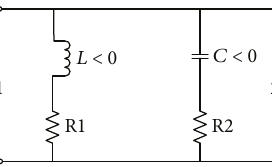
Figure 4: An unstable circuit which would be predicted to be stable by Rollett ’ s